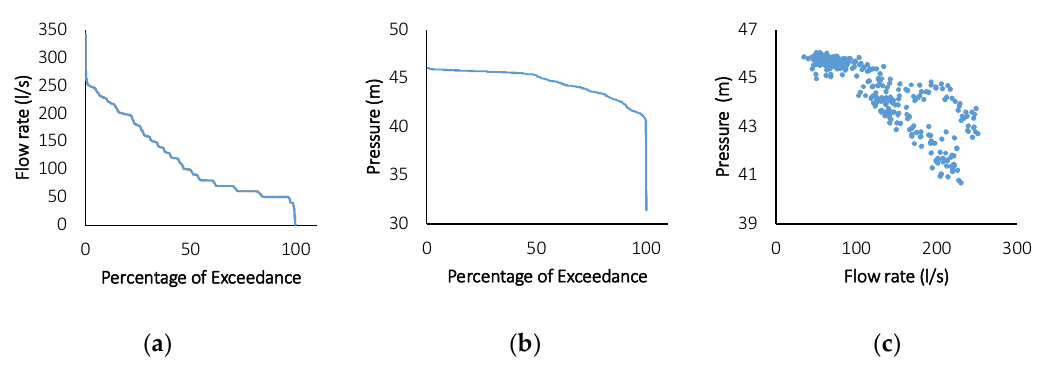
Figure 3. Annual duration curves of ( a ) the flow rate and ( b ) the pressure head. ( c ) Daily average pressure-head vs. flow rate variation.